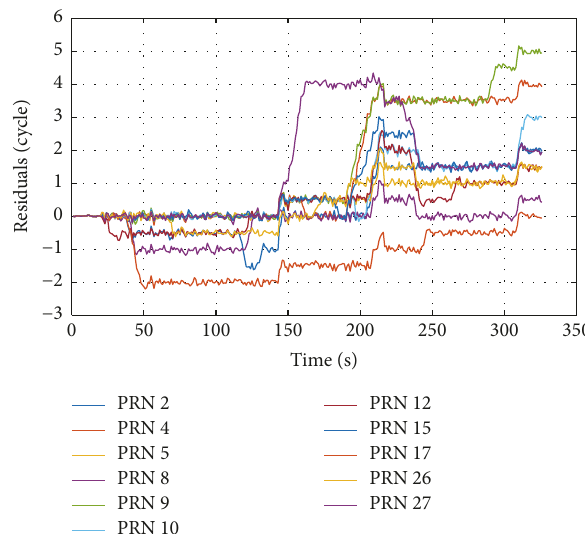
Figure 12: Single difference of carrier phase between 47dB-Hz and 15 dB-Hz data sets with the joint